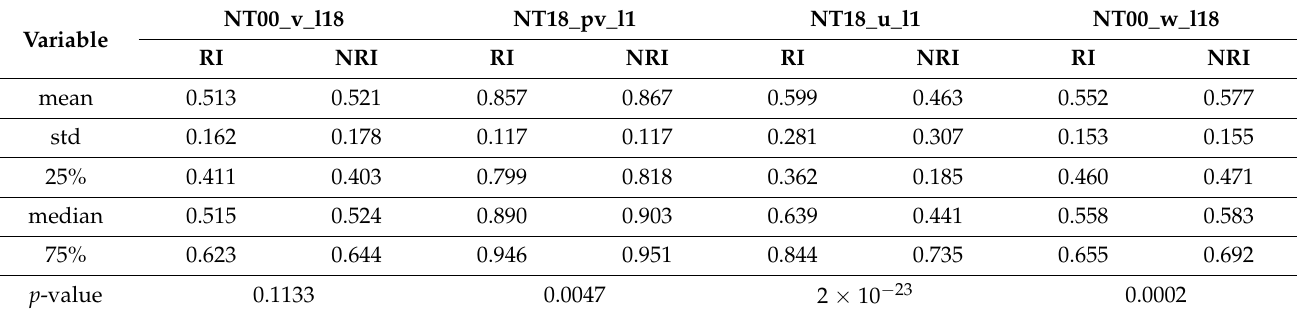
Figure 2. The value distribution for variable NT00_v_l18 (current 400 hPa meridional wind speed) over RI and non ‐ RI instances. The x ‐ axis represents the scaled value of the variable, the bar chart in the y ‐ axis represents relative frequency of the values falling in certain ranges, and the curves are the smoothed distribution via the kernel density estimation. The smoothed lines out of interval [0, 1] do not represent any valid value. Table 8. Basic statistic values for features NT00_v_l18, NT18_pv_l1, NT18_u_l1, and NT00_w_l18 for RI and non-RI (NRI) instances, respectively. The p-values are for the Mann–Whitney test against the same median in each